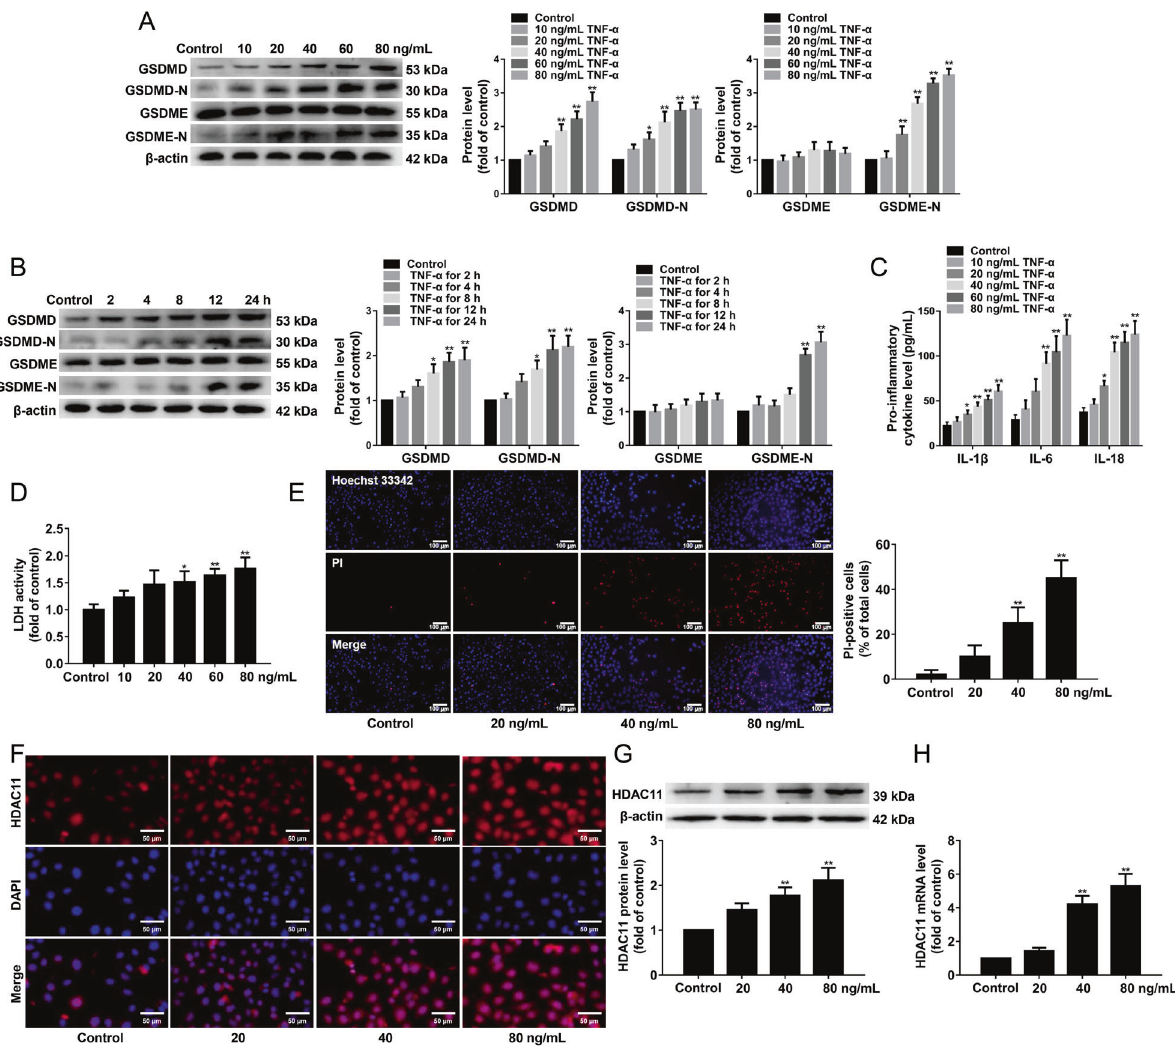
Fig. 2 TNF- α induces pyroptosis and upregulates HDAC11 expression in HUVECs. A HUVECs were treated with TNF- α (10, 20, 40, 60, or 80 ng/mL) for 12 h. GSDMD, GSDMD-N, GSDME, and GSDME-N protein expressions were determined by Western blotting. B HUVECs were treated with 40 ng/mLTNF- α for 2, 4, 8, 12, or 24 h. GSDMD, GSDMD-N, GSDME, and GSDME-N protein expressions were determined by Western blotting. C The levels of IL-1 β , IL-6, and IL-18 in the cellular supernatant were detected by ELISA assay. D The cellular supernatant LDH level was